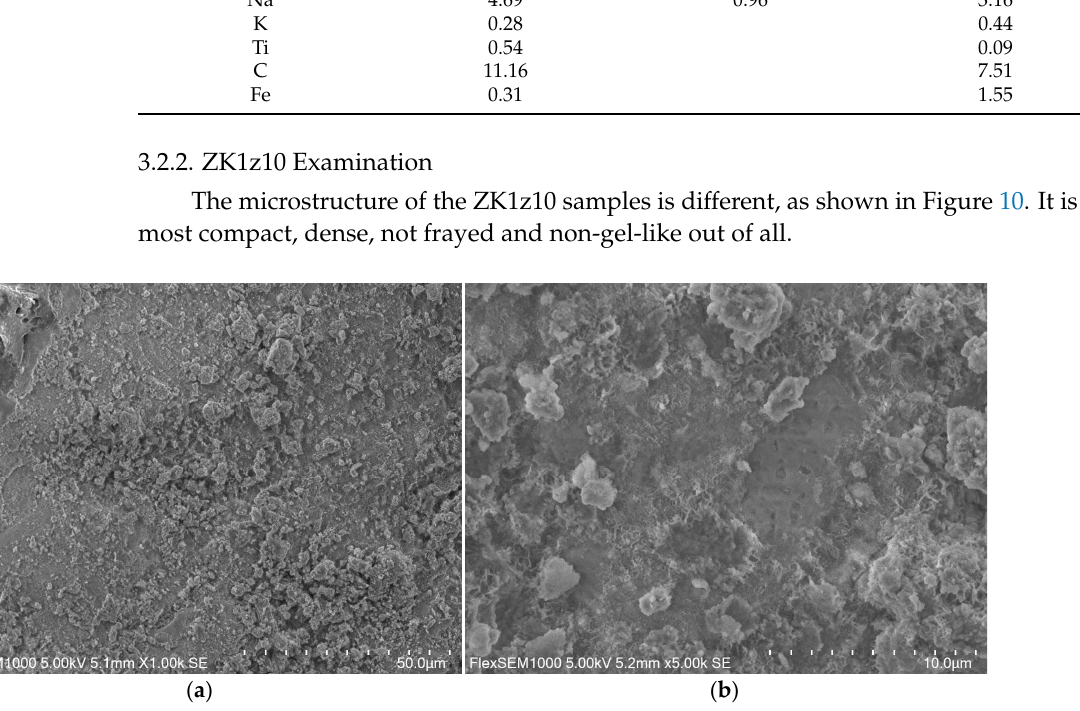
Figure 10. ZK1z10 microstructure prepared in magnification of: ( a ) 1000×; ( b ) 500×.